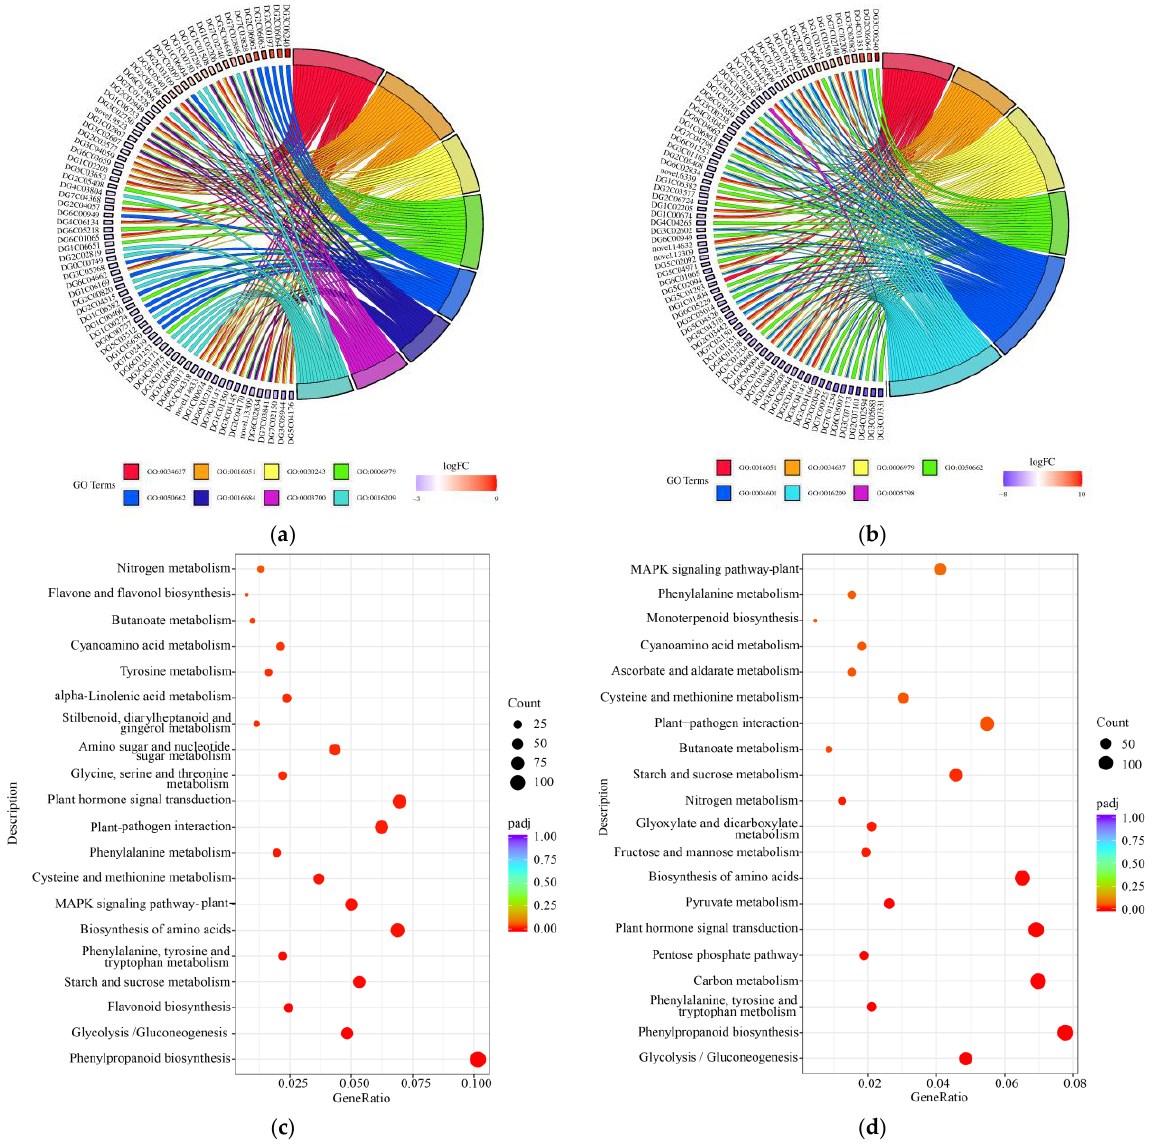
Figure 3. Functional enrichment analysis of differentially expressed genes (DEGs) in the roots of orchardgrass under submergence stress. 8 h vs. 0 h ( a ) and 24 h vs. 0 h ( b ). Partial GO terms chord diagram. Bubble diagram of top 20 enrichment pathways for 8 h vs. 0 h ( c ) and 24 h vs. 0 h ( d ).